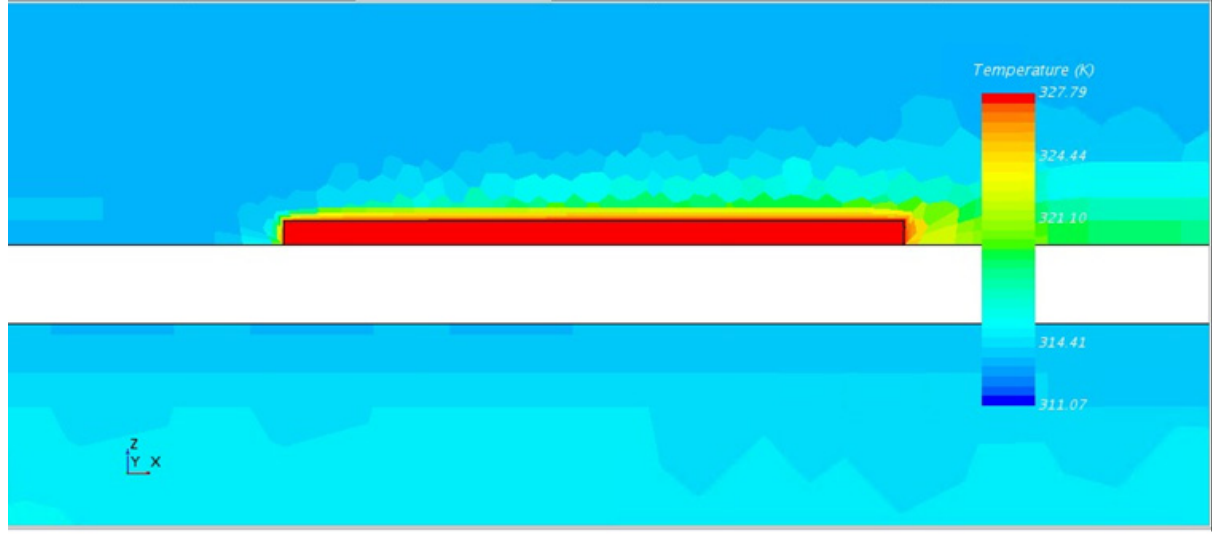
Figure 11. Mass fraction of water vapour distribution. 4. Conclusions A CFD simulation was implemented using a transient system model with the k- ε model for turbulence and the CFL criterion to understand the convective drying process. This is a handy and powerful tool to achieve the desired assessment to identify the tem- perature and air profiles in the convective drying chamber. The results of the air distribu- tion show that there are two specific areas of low air velocity that tend to create recircula- tion. They are located at the air exit and the other at the bottom of the chamber, which results in poor drying. Besides this, the temperature profile shows only a homogeneous drying in half of the trays (2, 3, and 4), reducing drying efficiency drastically, especially for the bottom ones. Air distributors or dampers are necessary to deliver and improve the convective chamber. The study has concluded that a redesign is needed to achieve the expected results from